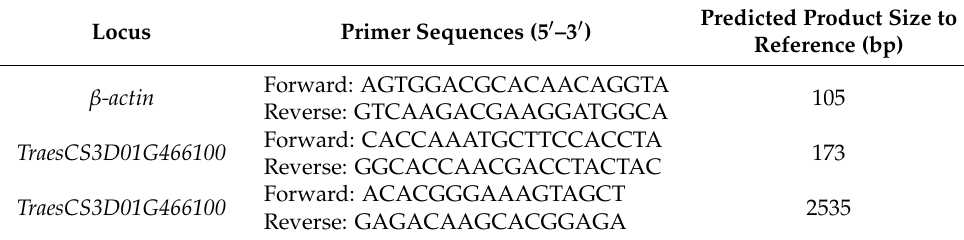
Predicted Product Size